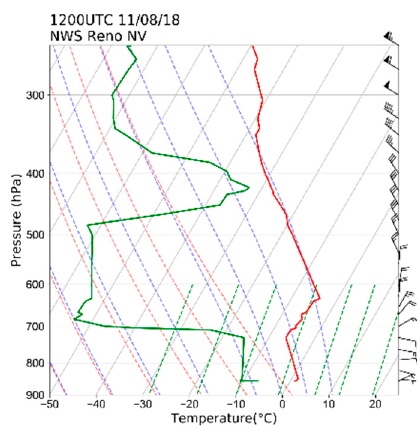
Figure 5. NWS Reno Nevada 12:00 UTC 8 November 2018 sounding.